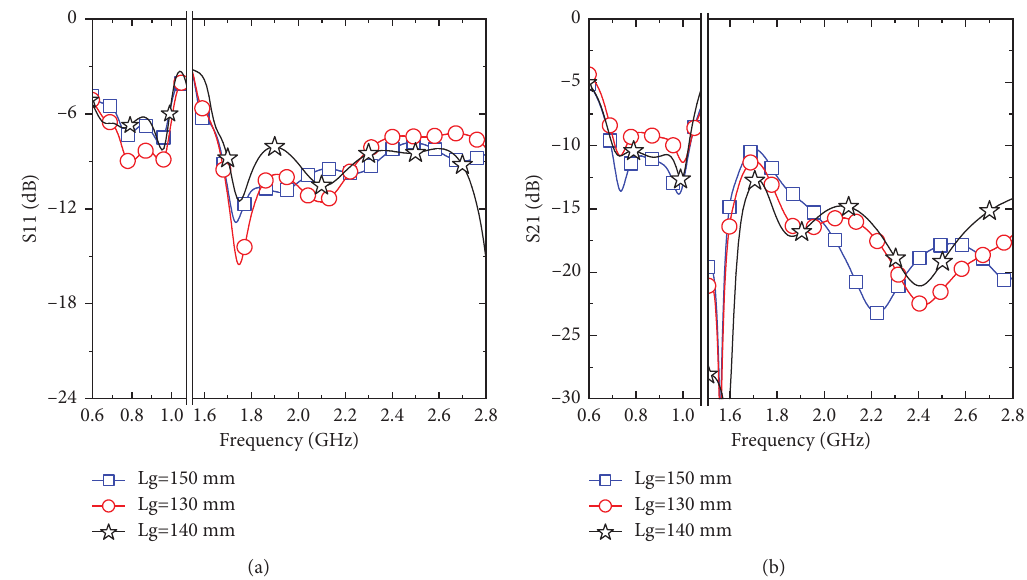
Figure 9: Effect of the ground length on the S-parameters. (a) S11. (b) S21.